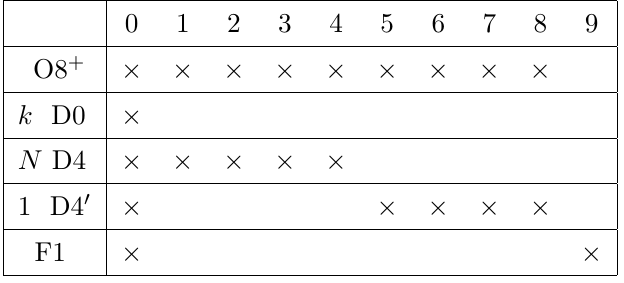
Table 3 . The directions of the various